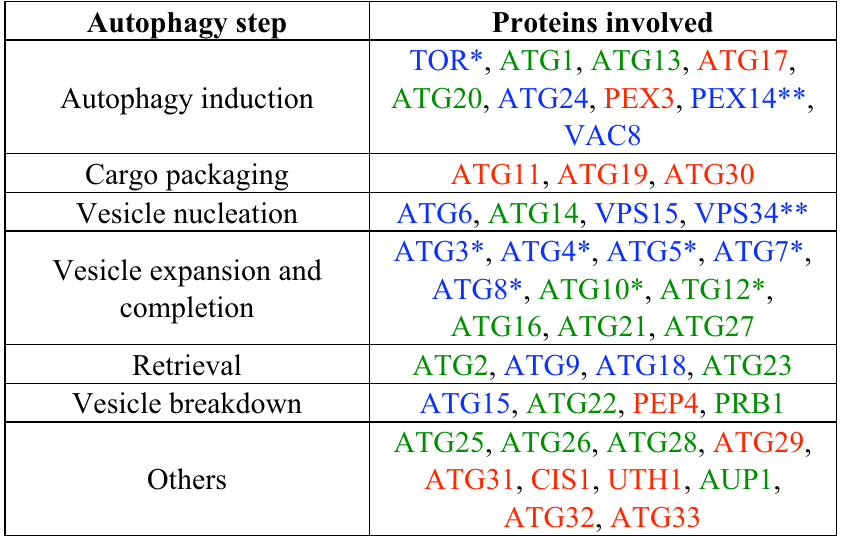
Table 1. Proteins predicted—by genomic searches—or proved to be involved in the successive steps of autophagy (see Figure 2) in trypanosomatids. In blue: proteins for which orthologues were found in the trypanosomatid genome databases. In green: proteins for which homologues (not orthologues) could be found in the trypanosomatid genomes. In red: proteins for which no orthologues or homologues were identified in the trypanosomatid genomes. One asterisk indicates proteins whose role in autophagy in trypanosomatids has been proved. Two asterisks indicate proteins that have been characterized in trypanosomatids, but their role in autophagy has not yet been determined. Details of the genomic searches, performed with known yeast and mammalian autophagy components, have been described previously